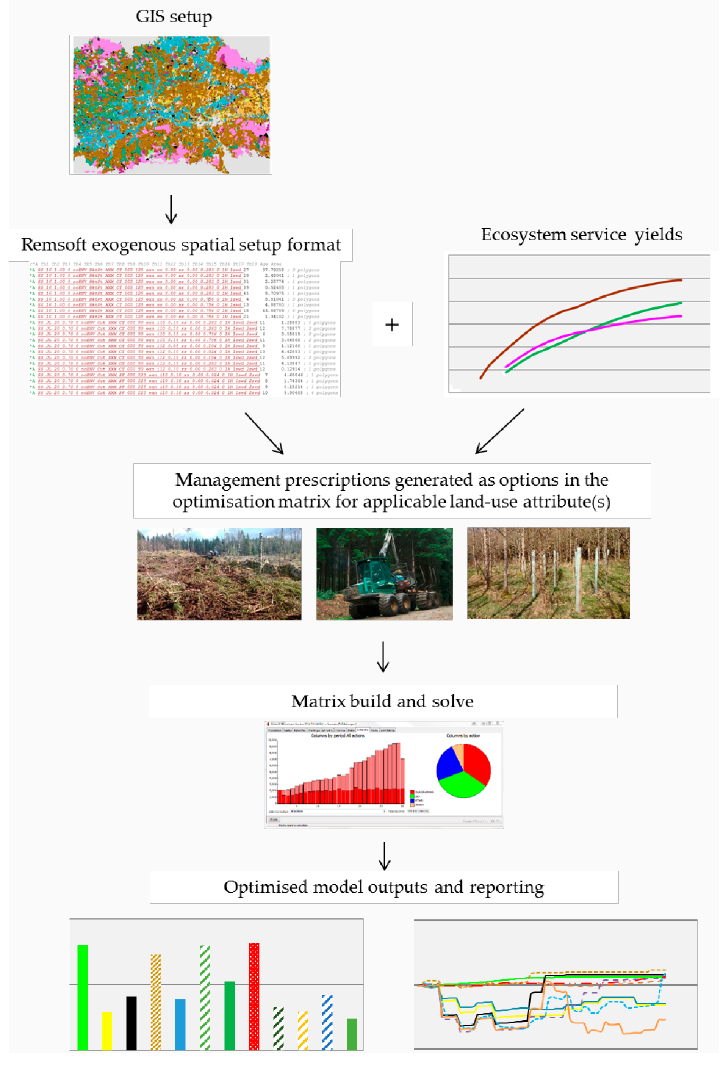
Figure 2. The essential steps and components in the biophysical modelling process.